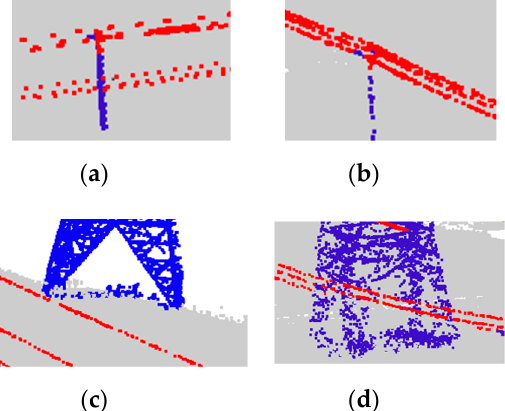
Figure 11. A zoomed-in view of the specific areas in Figure 10: ( a ) area A; ( b ) area B; ( c ) area C; and ( d ) area D.